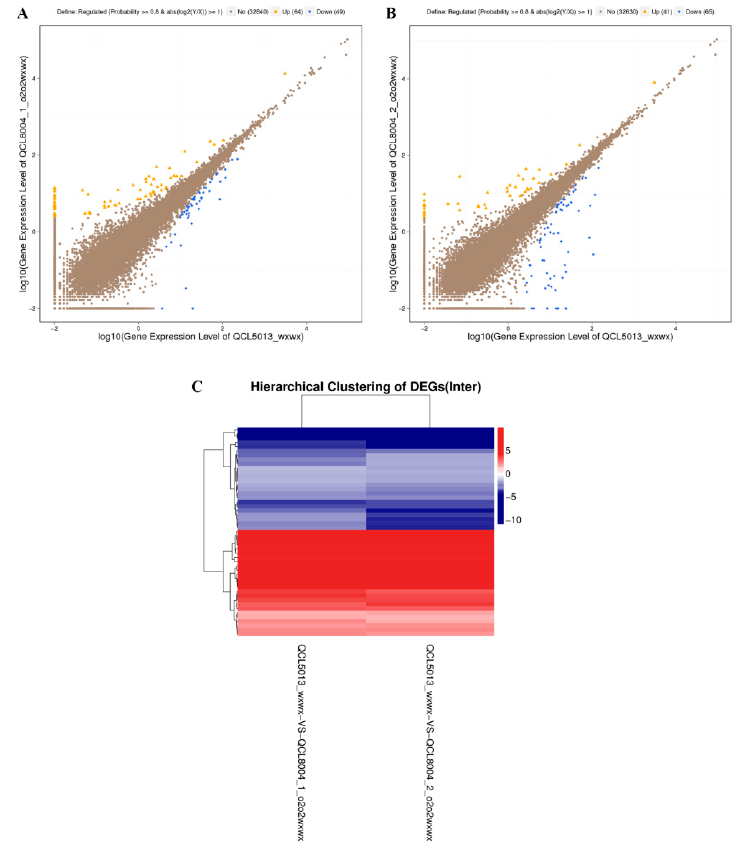
Figure 4. ( A ) Scatter plots of all expressed genes in each pairwise (QCL5013 vs. QCL8004_1). ( B ) Scatter plots of all expressed genes in each pairwise (QCL5013 vs. QCL8004_2). ( C ) Intersection heatmap of DEGs for each cluster